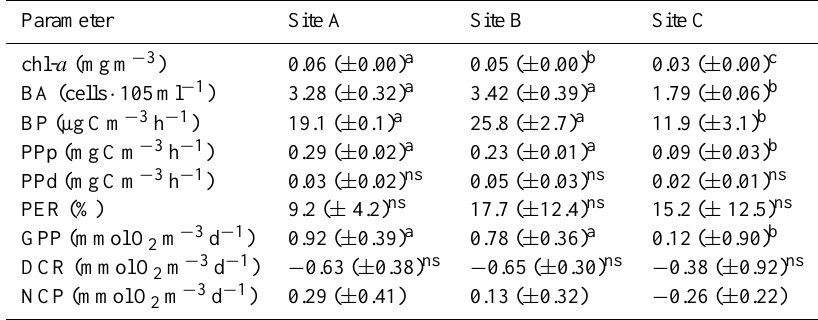
Table 2. Initial values (mean ± sd) of chl- a = Chlorophyll- a , BA = bacterial abundance, BP = bacterial production, PPp = particulate primary production, PPd = dissolved primary production, PER = percentage extracellular release, GPP = gross primary production, DCR = dark community respiration and NCP = net community production at stations A, B and C. For chl- a , BA, PPp and BP the standard deviation (sd) was estimated from the triplicate microcosms. For PPd and PER the sd was obtained from the triplicate measurement in a sin- gle microcosm while for GPP, NCP, DCR the sd was obtained from the quadruple measurements in each of the 2 microcosm (cf. Sect. 2.2.4). For each parameter, values labeled by different letters (a, b or c) in the three sites are significantly different at p < 0 . 05 while “ns” denotes that no significance difference was detected among the